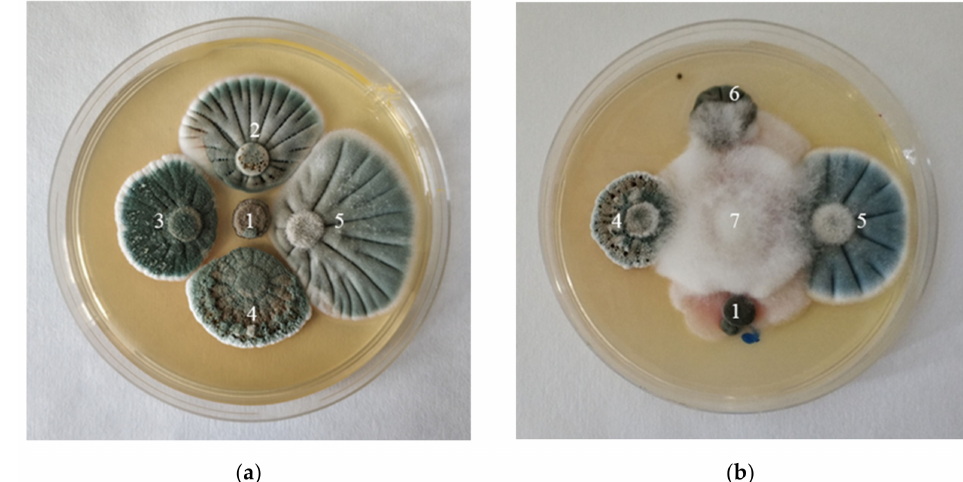
Figure 2. Antifungal activity of mold species tested in this study: ( a ) C. cladosporioides CCM F-348 (1), P. chrysogenum CCM F-362 (2), P. crustosum CCM F-8322 (3), P. griseofulvum CCM F-8006 (4), P. glabrum CCM F-310 (5); ( b ) C. cladosporioides CCM F-348 (1), P. griseofulvum CCM F-8006 (4), P. glabrum CCM F-310 (5), F. graminearum CCM F-683 (6), C. herbarum CCM F-455